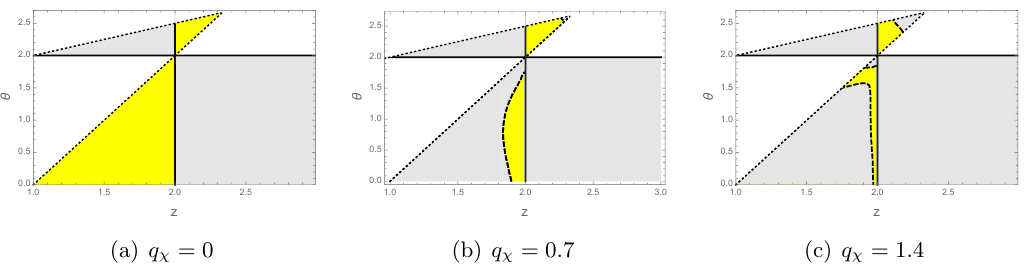
Figure 11 . Sign of the coe(cid:14)cient of H 2 of the thermal conductivity near H = 0. Yellow region denotes positive sign(WL) and gray region is for negative sign(WAL). Dotted line is for NEC. Here we use the same parameter of (cid:12)gure 10 and T = 0 : 16.